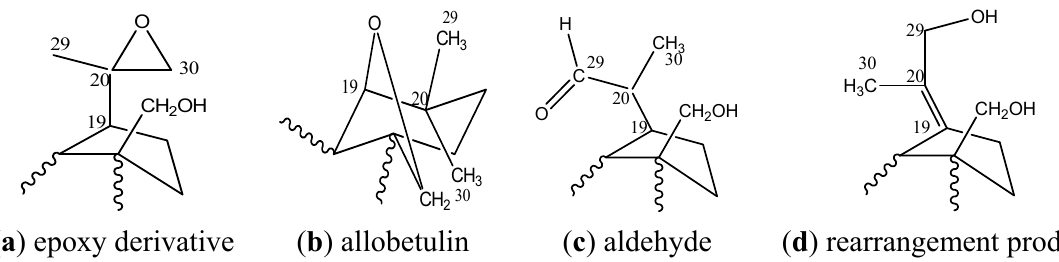
Figure 5. Proposed fragments of oxidation products of the isopropenyl